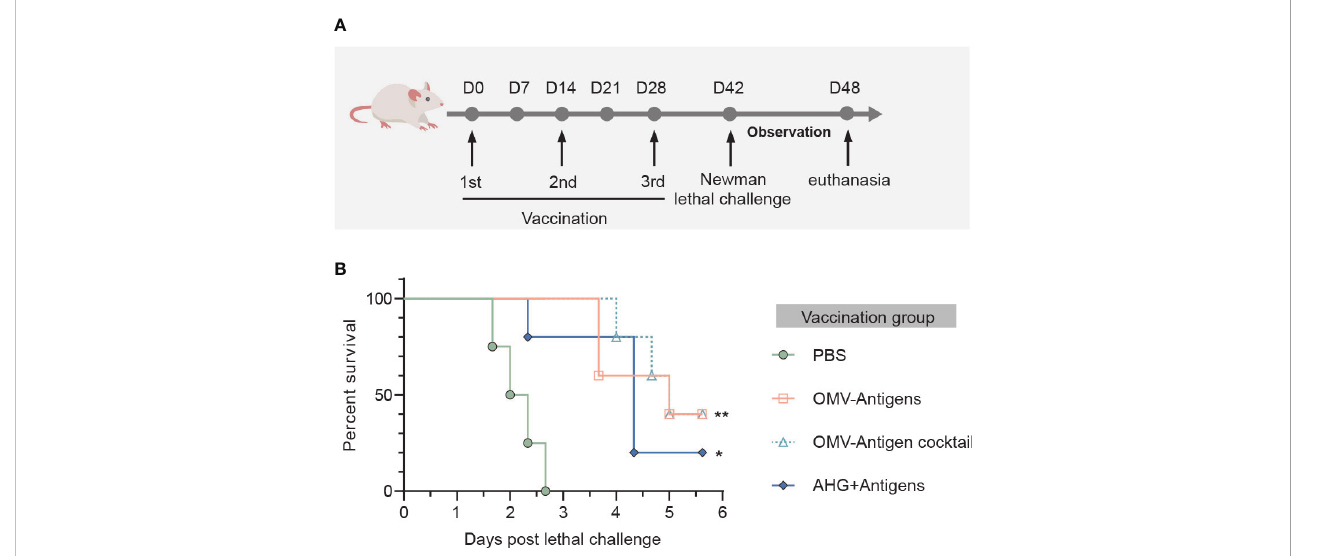
FIGURE 5 Immunization with the OMV-based click vaccine generated protective immunity against lethal challenge with S. aureus Newman. (A) Mice (n=5) were immunized with OMV-Antigens, OMV-Antigen cocktail, Antigens mixed with 10% AHG and PBS as a control. Lethal dose of S. aureus Newman was injected intravenously 7 days post the third immunization and the survival of mice were monitored afterwards. (B) The survival curve of the mice in different immunization groups. Statistical analysis was performed by the Log-rank (Mantel-Cox) test. *P < 0.05; **P <